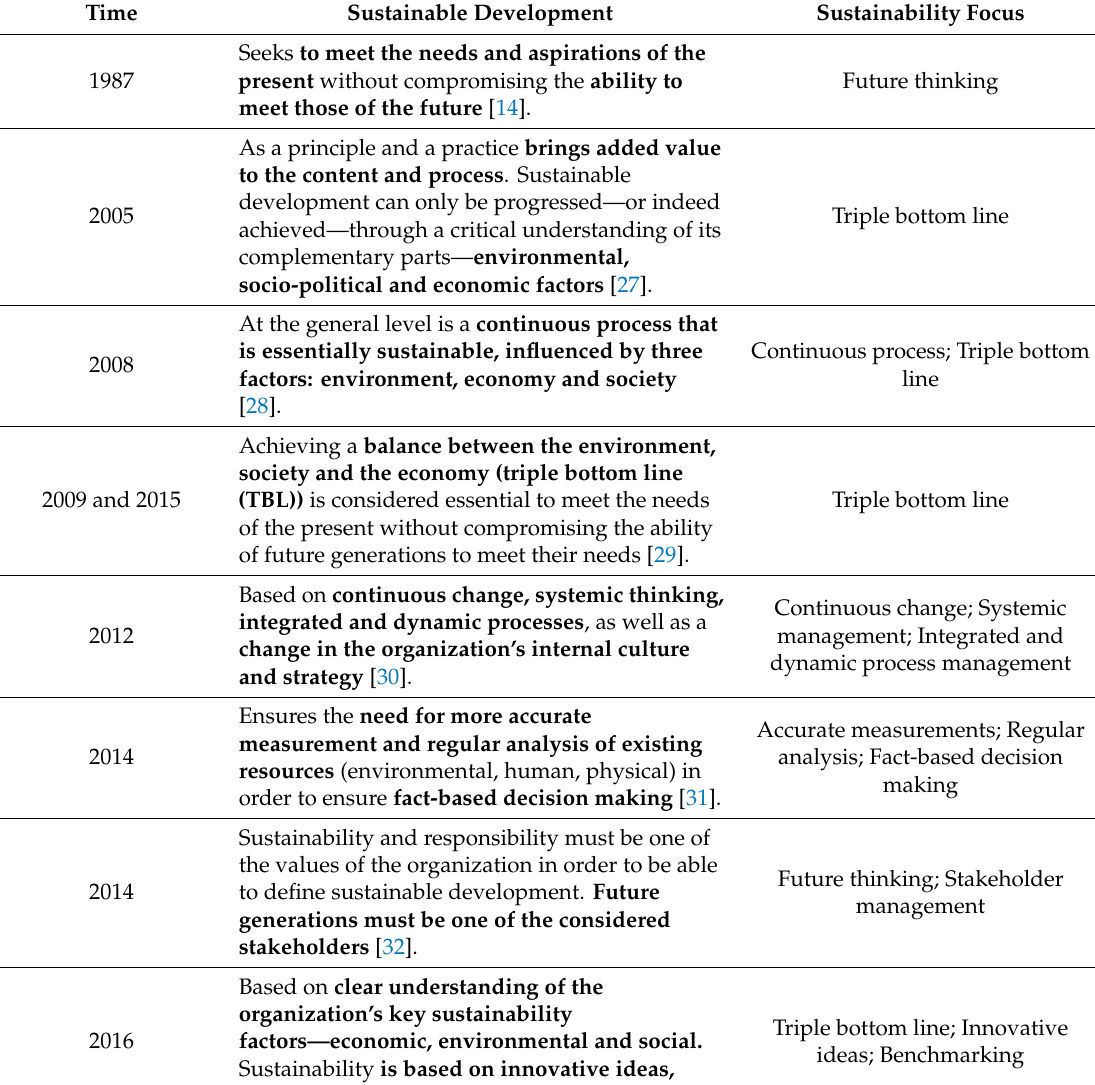
Table 1. The comparison of the concepts of sustainable